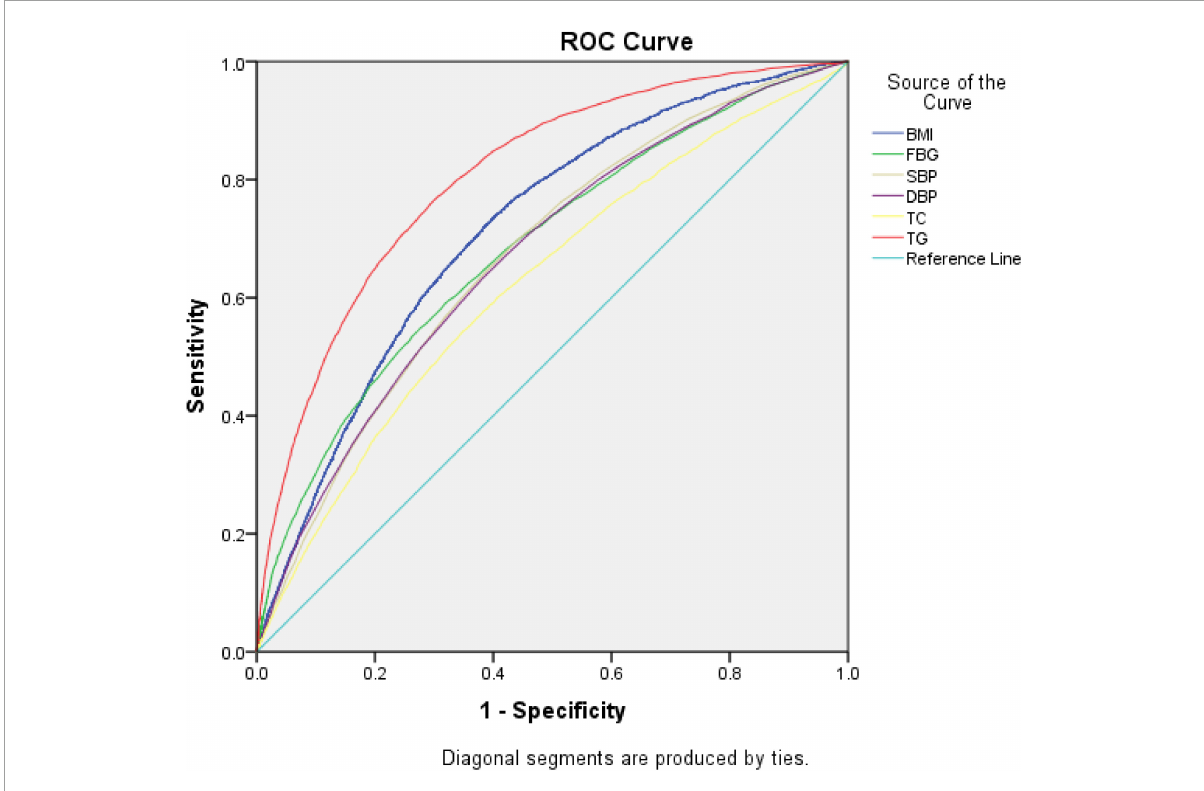
FIGURE1 Receiver operating characteristic (ROC) curve for predicting the occurrence of non-obese fatty liver disease.